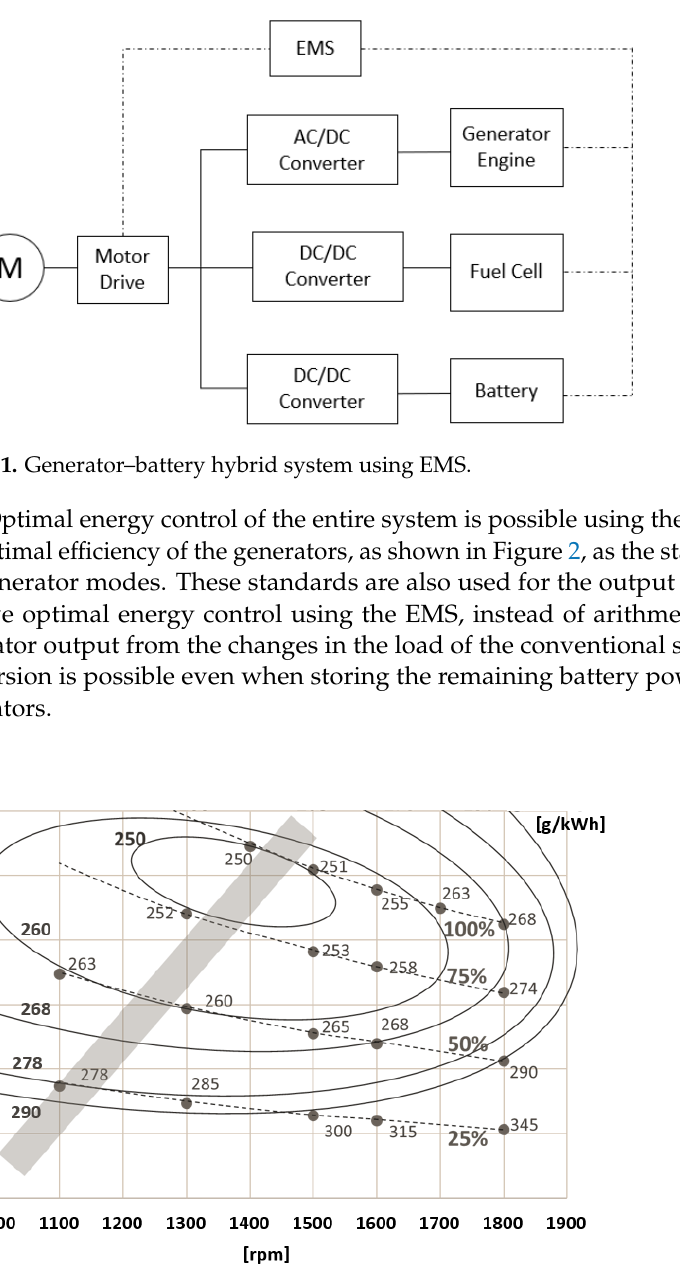
Figure 2. Specific fuel oil consumption and torque based on the speed and output of variable-speed generator.